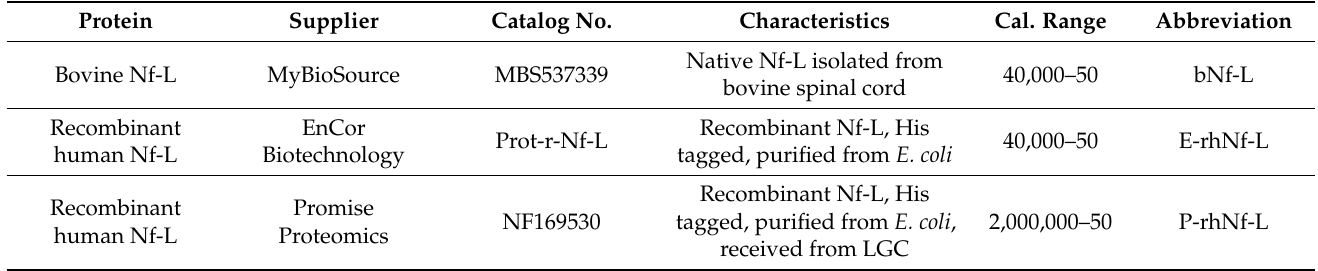
Table 5. Full-length neurofilament light chain calibrators evaluated for Nf-L